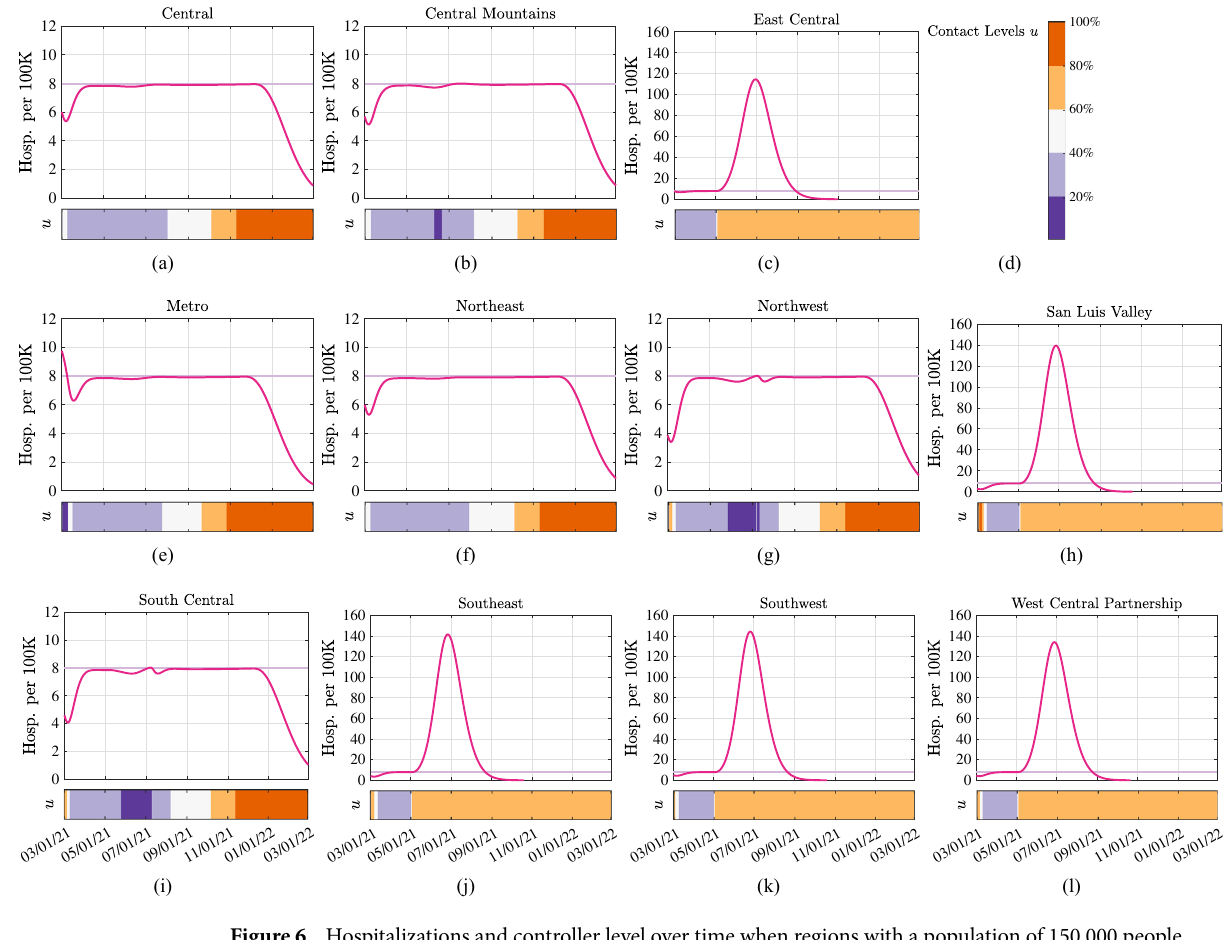
Figure 6. Hospitalizations and controller level over time when regions with a population of 150,000 people or less (i.e., East Central, San Luis Valley, Southeast, Southwest, West Central Partnership) drop all NPIs on 05/01/21. Simulation conducted with vaccination rate y = 20, 000 vax/day. Each of the 11 panels shows the evolution in time in a different LPHA region (see Fig. 4 for an illustration of the connectivity graph). Solid magenta lines illustrate the evolution of the hospitalized state, light purple lines show the pre-specified hospitalization limit. Heat maps illustrate the required level of NPIs u i , as determined by the controller. Note that y-scale differs between